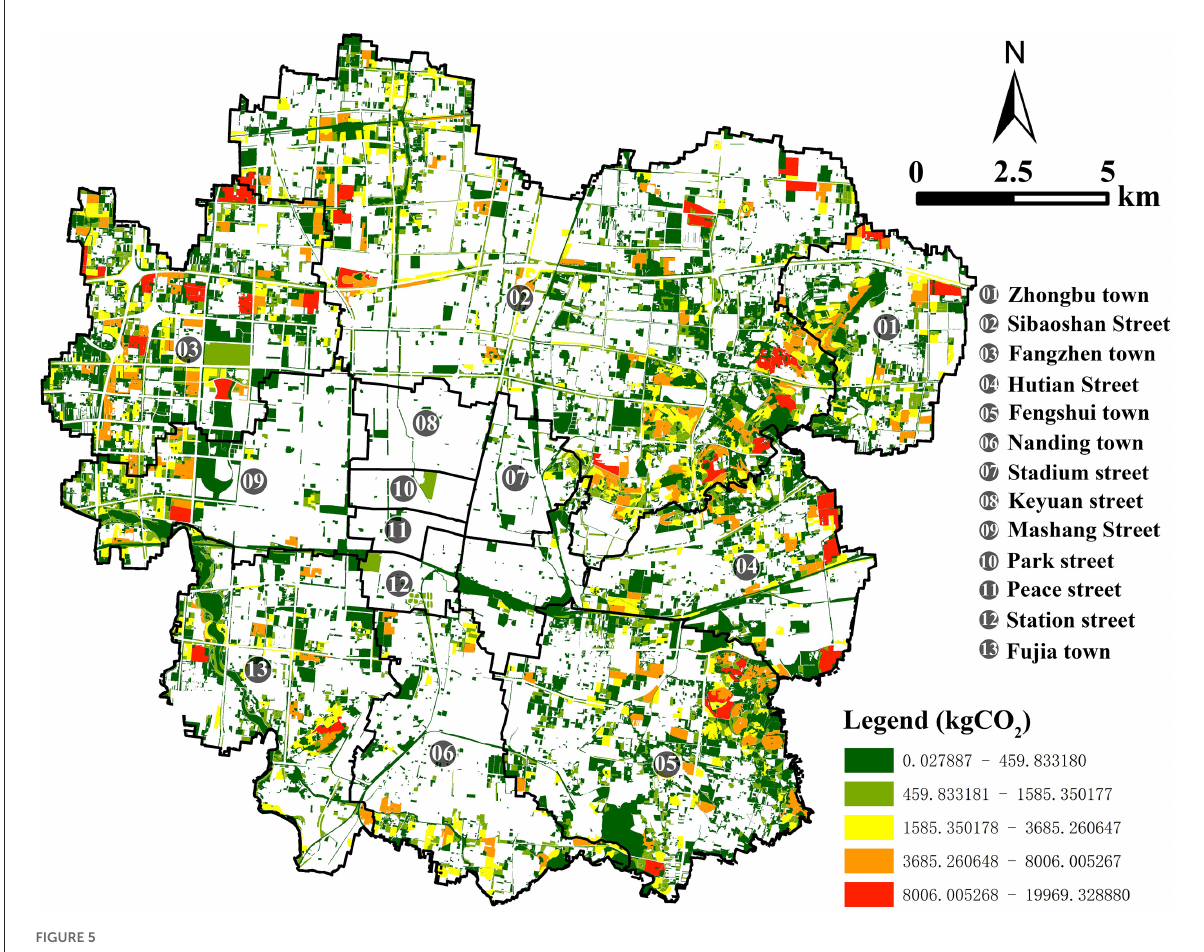
FIGURE5 Carbon absorption map of Zhangdian.